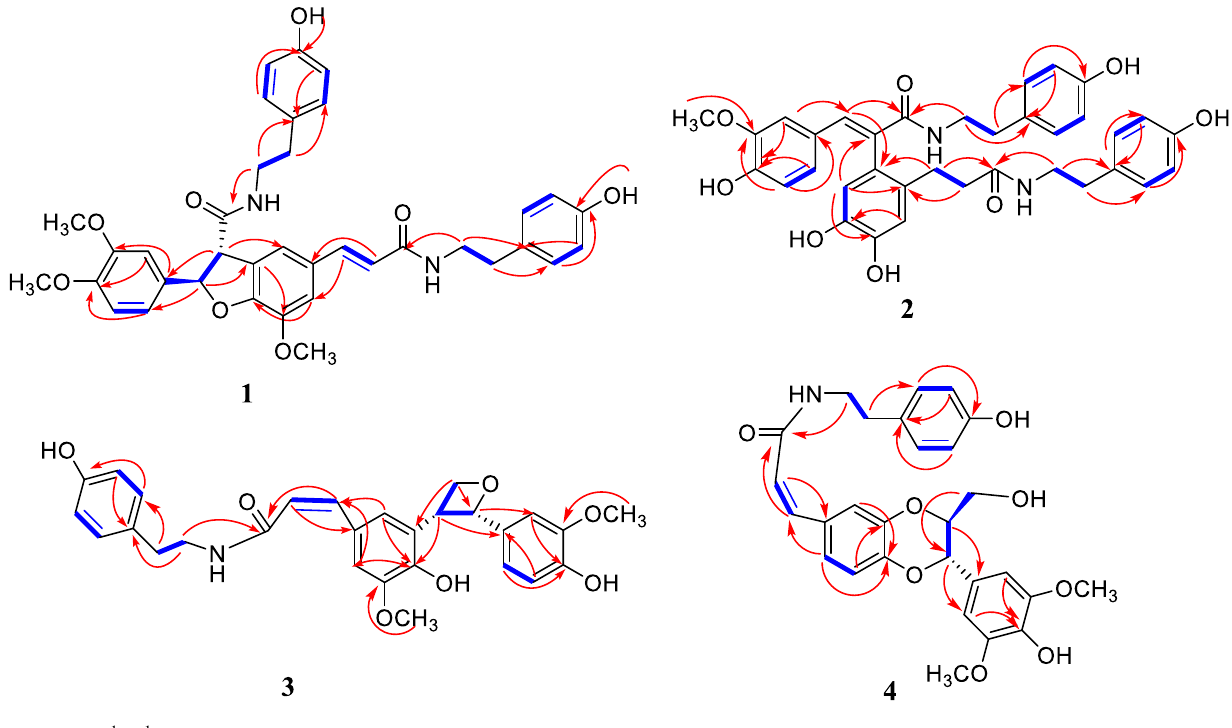
Fig. 2 Key 1 H– 1 H COSY